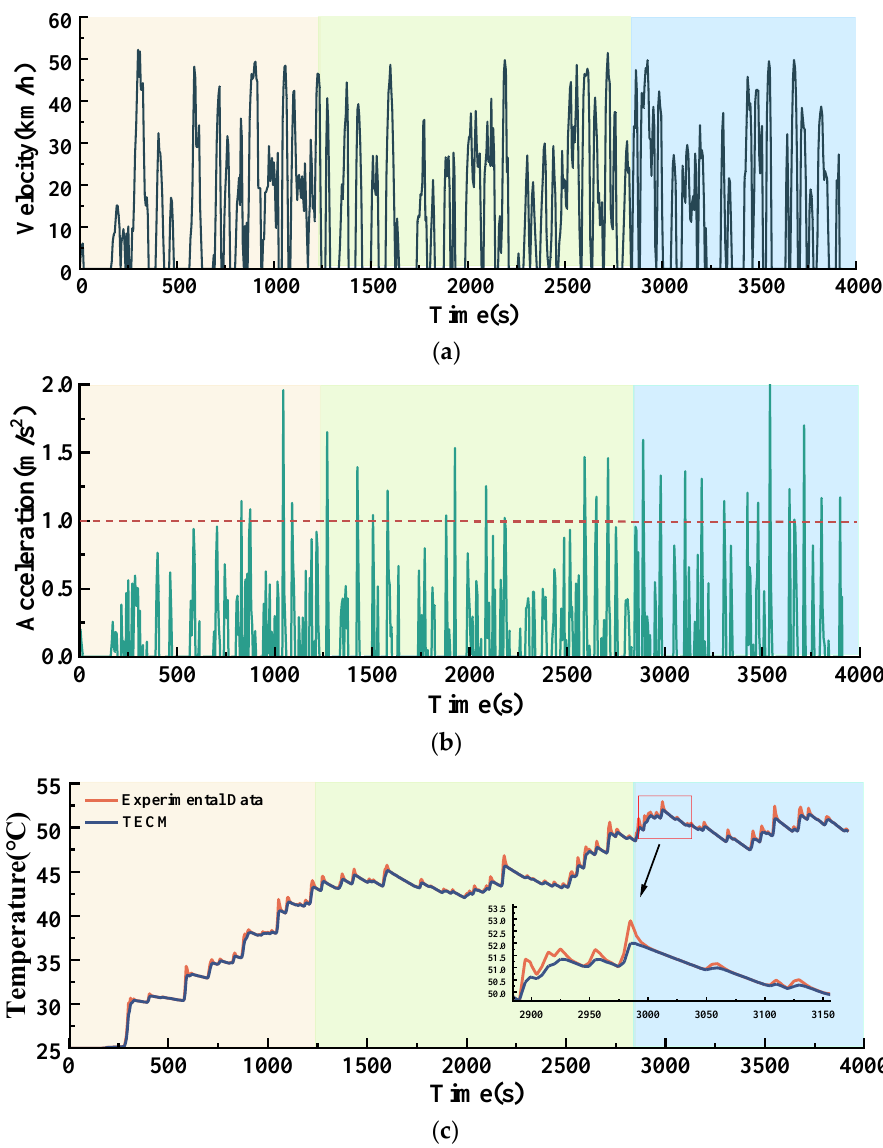
Figure 14. Bus driving cycle ( a ) velocity, ( b ) acceleration and ( c ) temperature compared between TECM and experimental data.